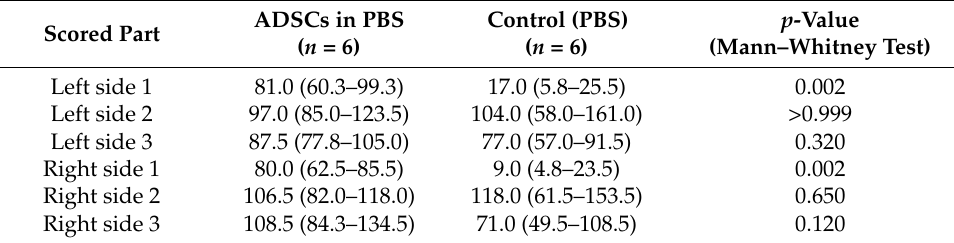
Table 1. Immunohistochemical analysis of olfactory marker protein expression in the olfactory epithelium of mice 14 d after left side nasal administration of ADSCs or PBS.